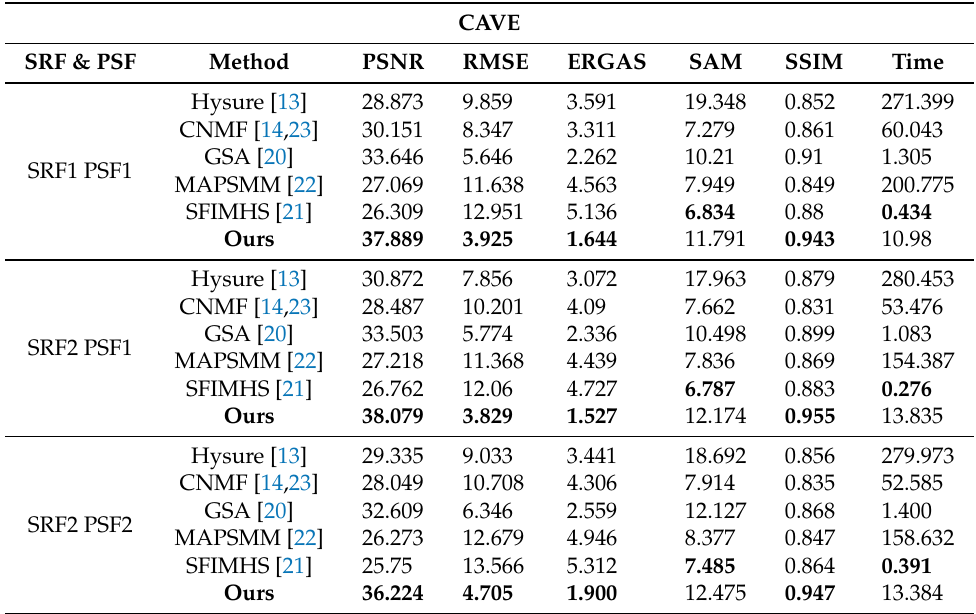
Table 5. Objective evaluation metrics for the fusion results of the six blind fusion methods in the paper on the CAVE